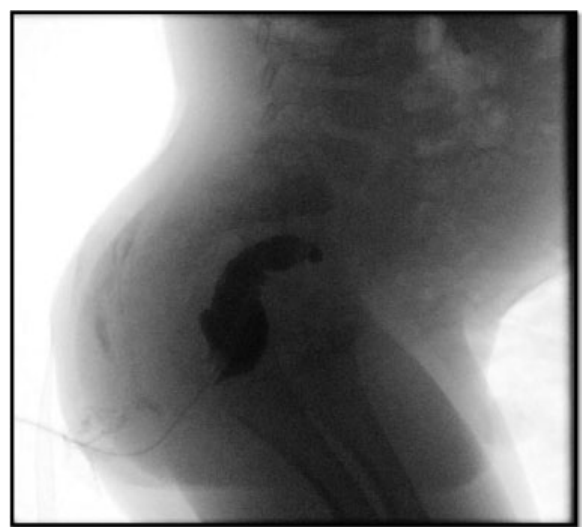
Fig. 2 A 2-year-old at relook of the perineum for removal of packs 48hours post laparotomy, resection of necrotic rectum, and sigmoid colon and end